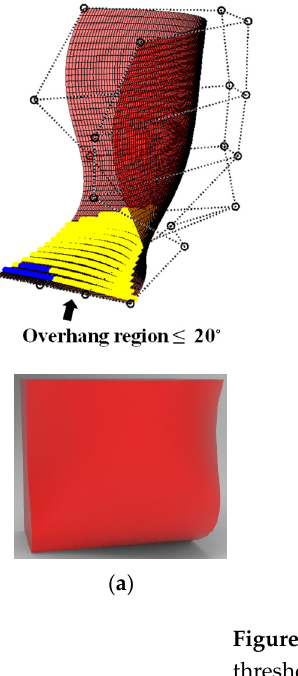
Table 7. Comparison of fabrication cases.